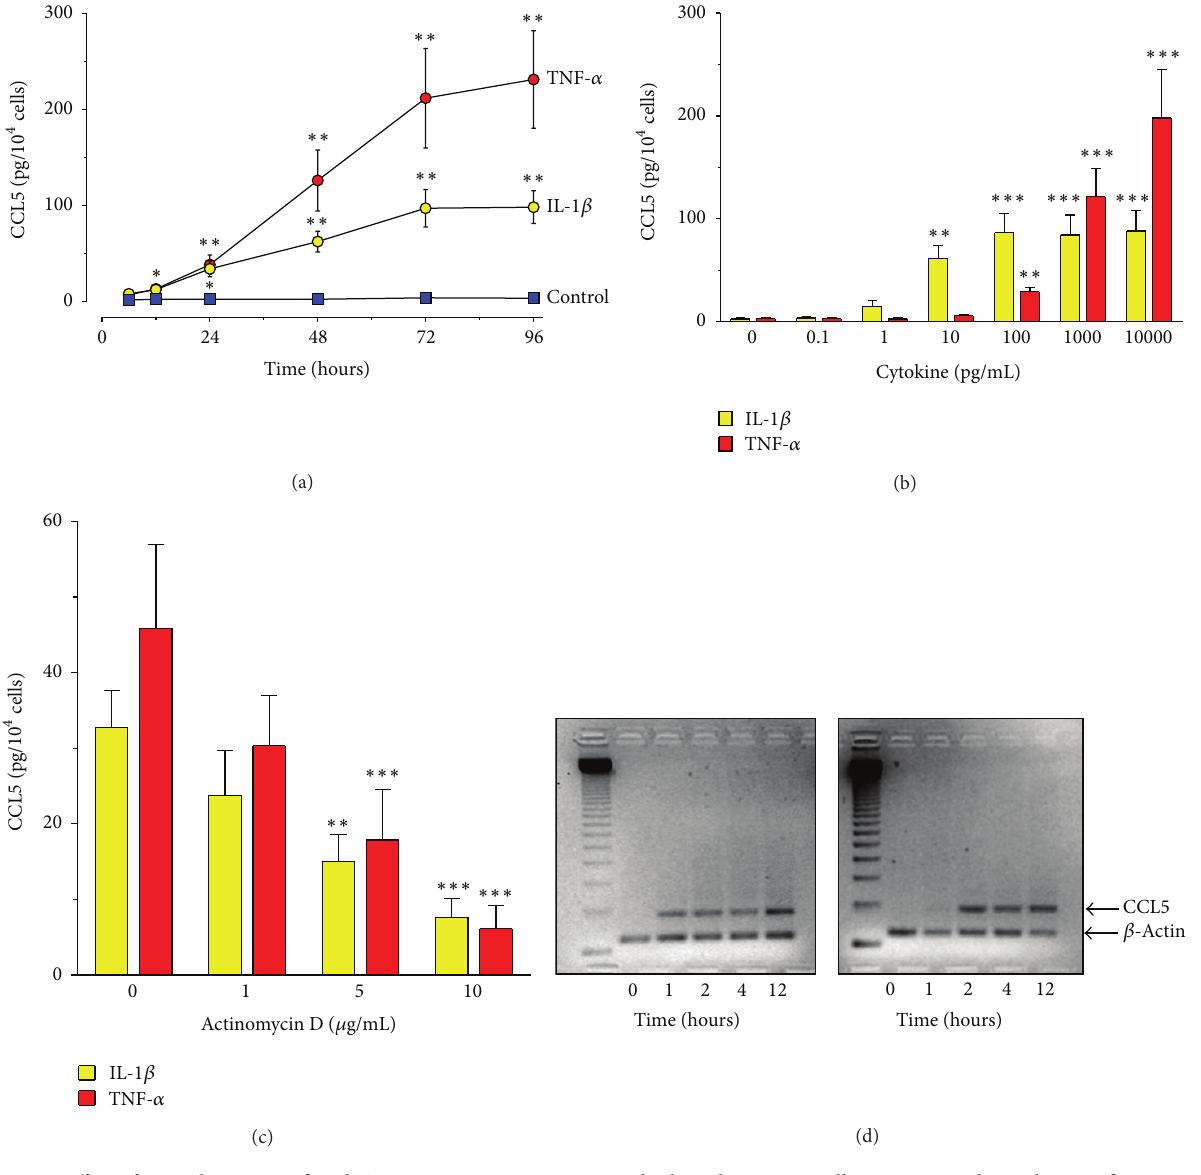
Figure 1: Effect of recombinant IL-1 𝛽 and TNF- 𝛼 on CCL5 expression and release by HPFB. Cells were exposed to either IL-1 𝛽 or TNF- 𝛼 . The data were derived from experiments with cells isolated from separate donors. (a) Kinetics of IL-1 𝛽 -induced (1000 pg/mL) or TNF- 𝛼 - induced (1000 pg/mL) CCL5 secretion ( 𝑛 = 6 ); (b) dose effect of IL-1 𝛽 or TNF- 𝛼 . Cells were stimulated for 48 hours ( 𝑛 = 6 ); (c) effect of actinomycin D on CCL5 release by HPFB. Cells were pretreated for 1 hour with actinomycin D and then exposed to either IL-1 𝛽 or TNF- 𝛼 (both at 1000 pg/mL) for 24 hours ( 𝑛 = 6 ); (d) time effect of IL-1 𝛽 and TNF- 𝛼 on CCL5 mRNA expression. HPFB were treated with cytokines at 1000pg/mL for the times indicated. CCL5 mRNA expression was analysed by semiquantitative RT-PCR. Results of a representative experiment of three